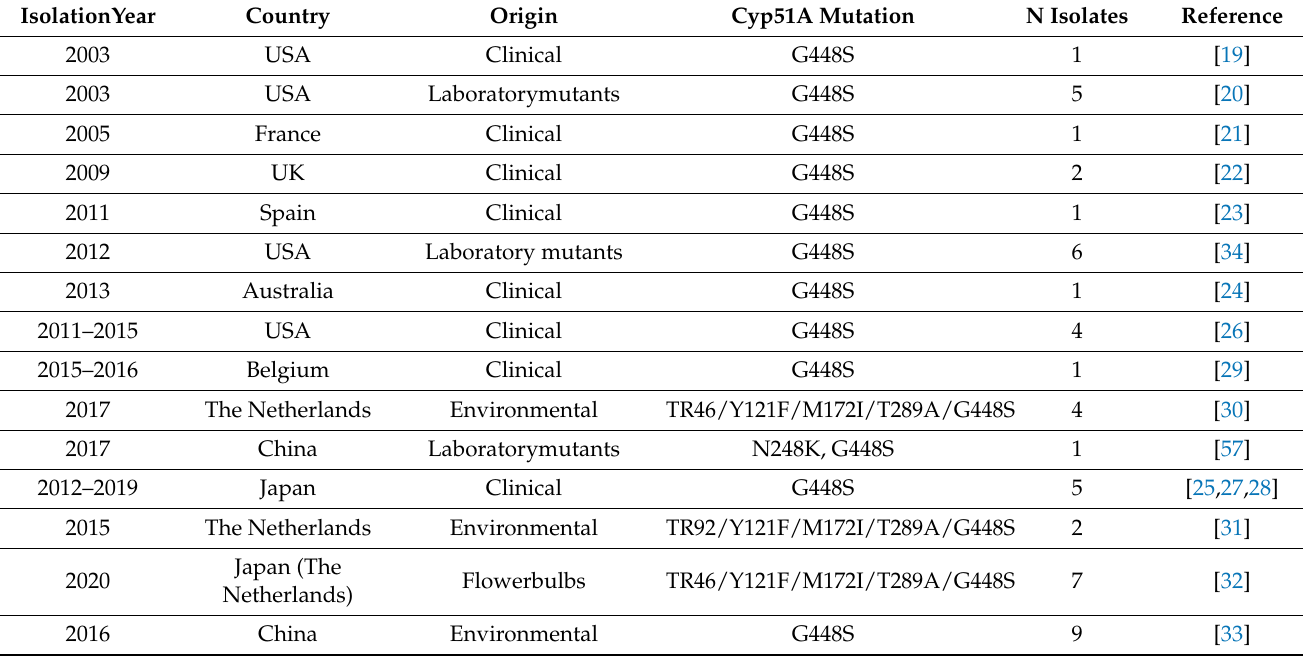
Table 2. Reported Aspergillus fumigatus isolates harboring the mutation G448S in Cyp51A.